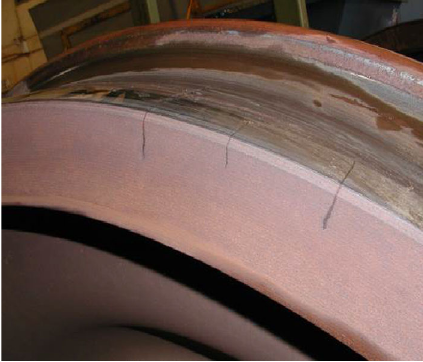
Fig. 2 Thermal fatigue cracking developed at front rim face